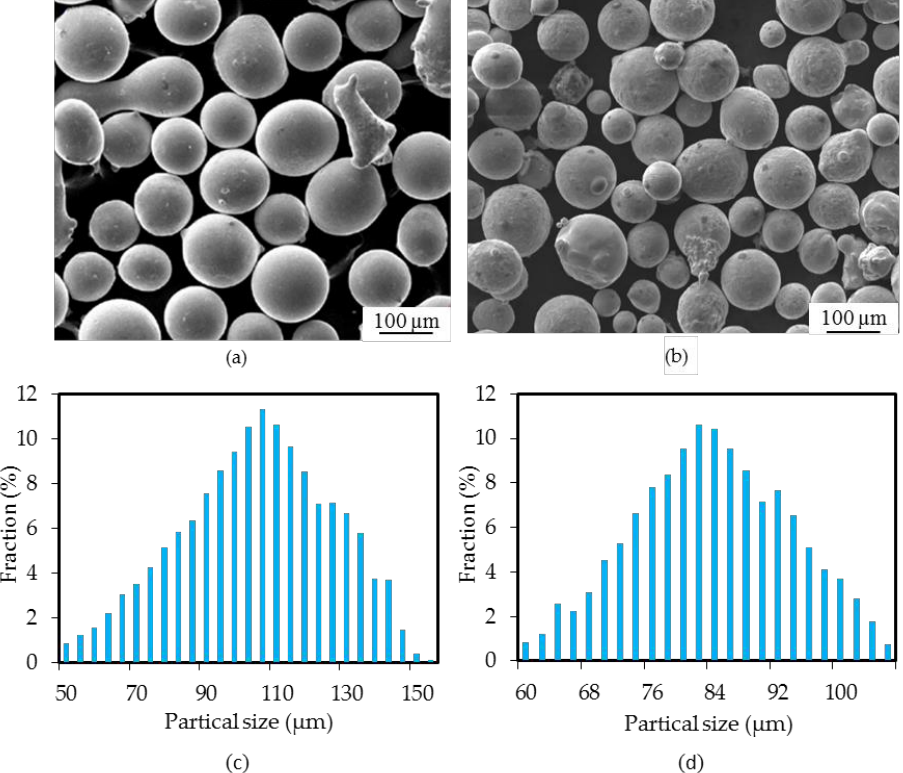
Figure 1. SEM images and powder particle size distribution of ( a , c ) Inconel 718 and ( b , d ) CuSn15. Table 1. The chemical composition of Inconel 718, CuSn15 and HT250 for LDED (wt.%). Material